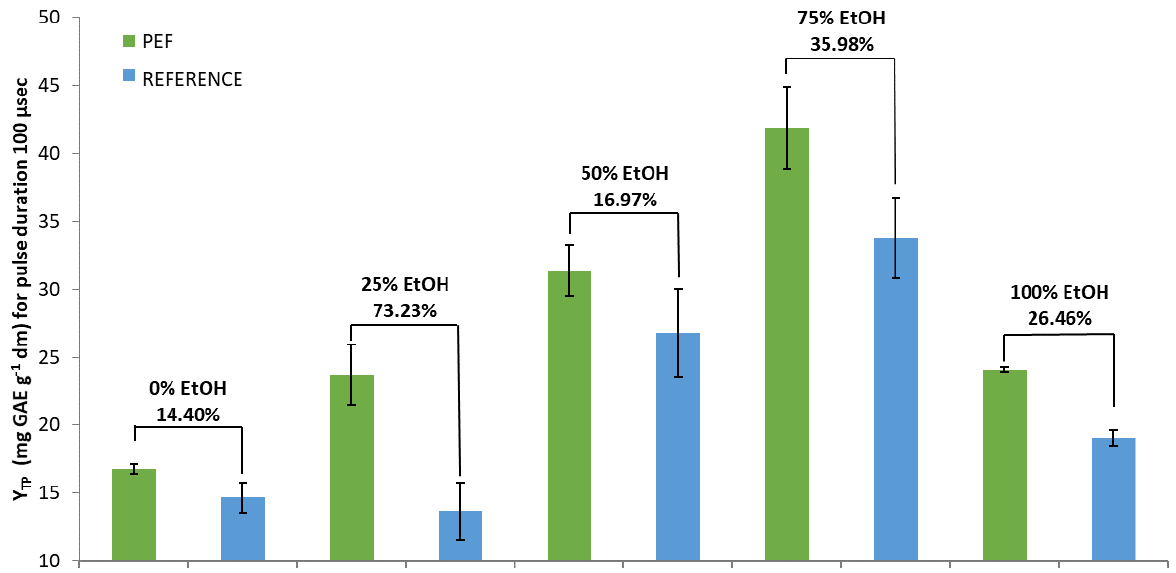
Figure 2. Y TP for PEF treated and Reference extracts in five different tested solvents and a pulse duration of 100 μs . Y TP is the total polyphenol yield.